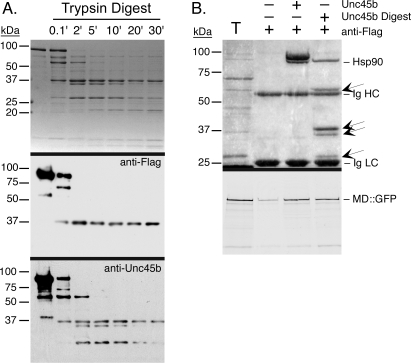
Characterization of the domain structure of Unc45b by limited proteolysis.A. Time course of the digestion of Unc45bFlag with trypsin reveal a ∼37 kDa fragment that appears early in the digest and is relatively stable for up to 30 min. Other initial fragments include a 60 kDa fragment that disappears with the appearance of a 34 kDa and 26 kDa fragment. Western blotting with anti-Flag mAb shows that the 37 kDa fragments retains the C-terminal Flag epitope and corresponds most of the UCS domain. The anti-Unc45b antibody identifies the four early fragments and monitors their disappearance. B. Pull-down assay with anti-Flag beads to determine if the 37 kDa fragment bearing the Flag tag is still capable of binding the myosin motor domain synthesized in the reticulocyte lysate. The fragments produced by 2 min trypsin digestion were incubated with skeletal muscle MD::GFP chimera. The upper panel is the stained gel and the lower panel the autoradiograph. The 60, 37, 34 and 26 kDa Unc45bFlag fragments (marked by arrows) are all pulled-down along with the 37 kDa fragment by the anti-Flag beads. Not only do they all remain associated with the 37 kDa fragment, the protease clipped protein retains myosin motor domain and Hsp90 binding activity comparable to intact Unc45bFlag. Lane T is the translation mix alone.